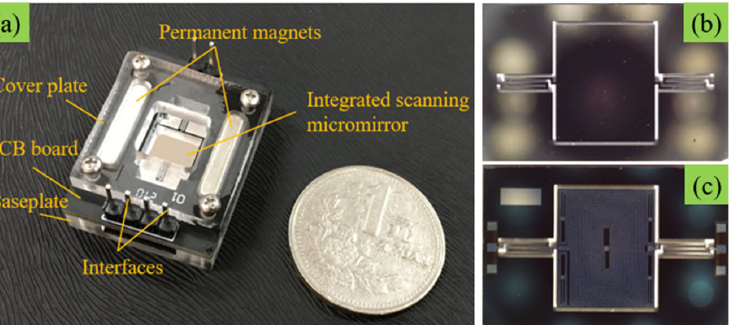
Figure 3. ( a ) The photograph of the electromagnetic ISM, ( b ) front side of the ISM chip, ( c ) back side of the ISM chip.